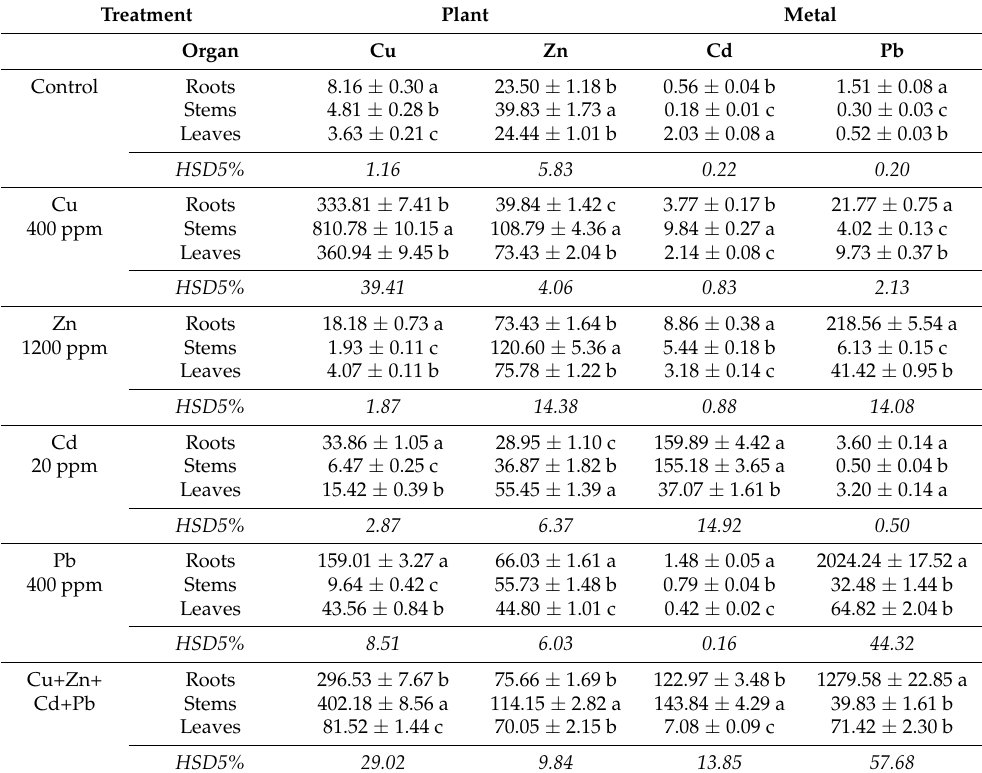
Table 1. Heavy metal concentrations in organs of S. perfoliatum plants grown under different treatments. Treatment